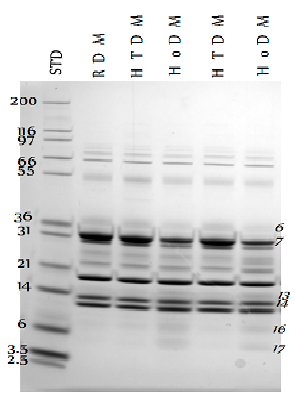
Figure 1. NuPAGE ® Protein profile of donkey milk before (RDM—raw donkey milk) and after HTST (HTDM—HTST donkey milk) and Holder (HoDM—holder donkey milk) pasteurization. STD: Mark12 ® Unstained Protein Standard (Life Technologies), KDa. Numbers on the right indicate significantly different protein bands. Table 2. Image analysis derived relative intensity data of protein bands in donkey milk before (RDM—raw donkey milk) and after HTST (HTDM – HTST donkey milk) and Holder (HoDM—holder donkey milk) pasteurization. SD: standard deviations (N = 4). Letters indicate post-hoc classes according to Tukey’s test when variation in band intensity was above 25%. NS: not significant. * p < 0.05; ** p < 0.01; *** p < 0.001.